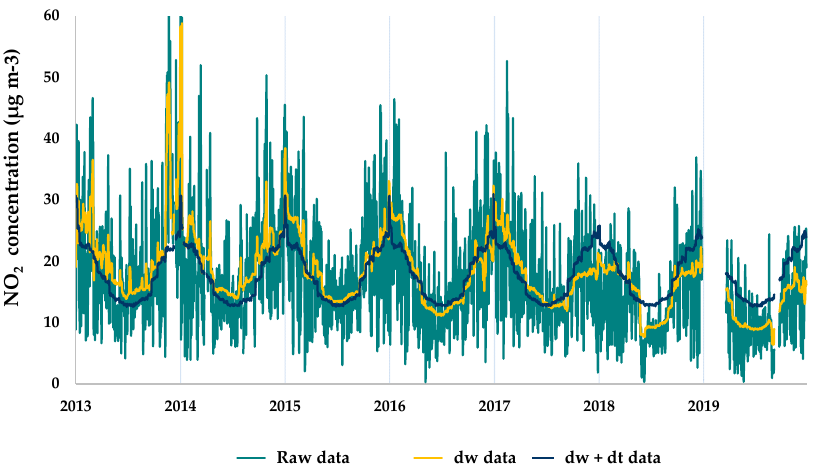
Figure 4. Trend analysis for NO 2 concentrations from 2013 to 2019 at the Zapatón site, using the “TheilSen” function. Overlaid is shown the slope with the 95% confidence intervals ( p -value < 0.005).